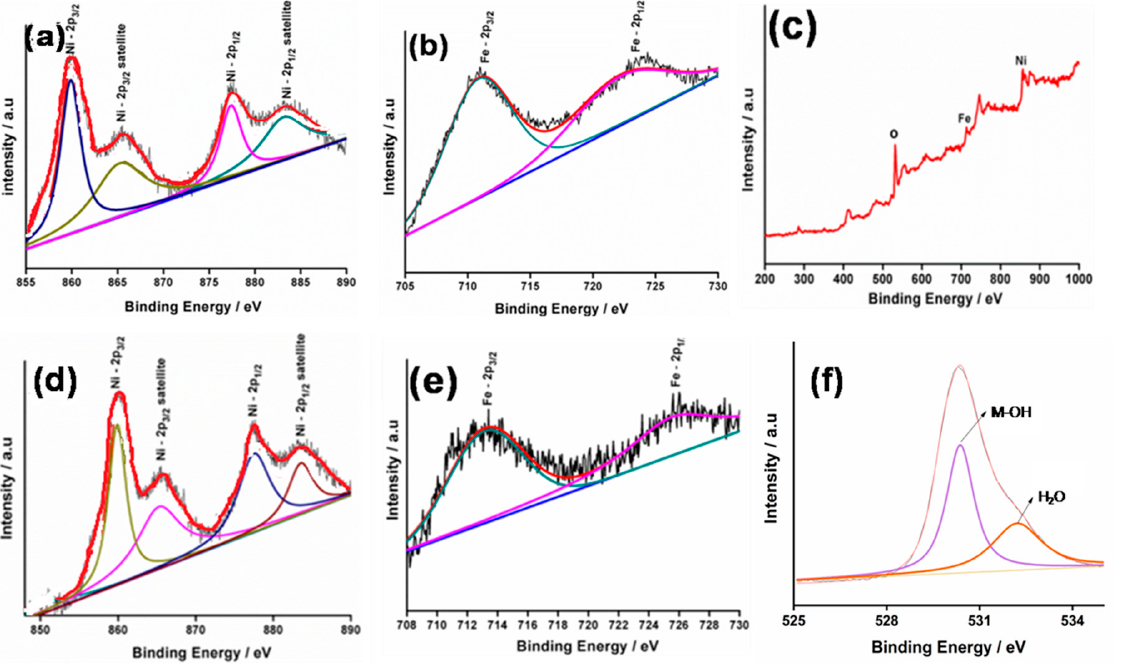
Figure 6. ( a ) Ni 2p and ( b ) Fe 2p XPS spectra, ( c ) XPS survey spectrum of NiFe-LDH, ( d ) high-resolution spectra of Ni 2p, ( e ) Fe 2p, and ( f ) O1s for NiFe-LDH.